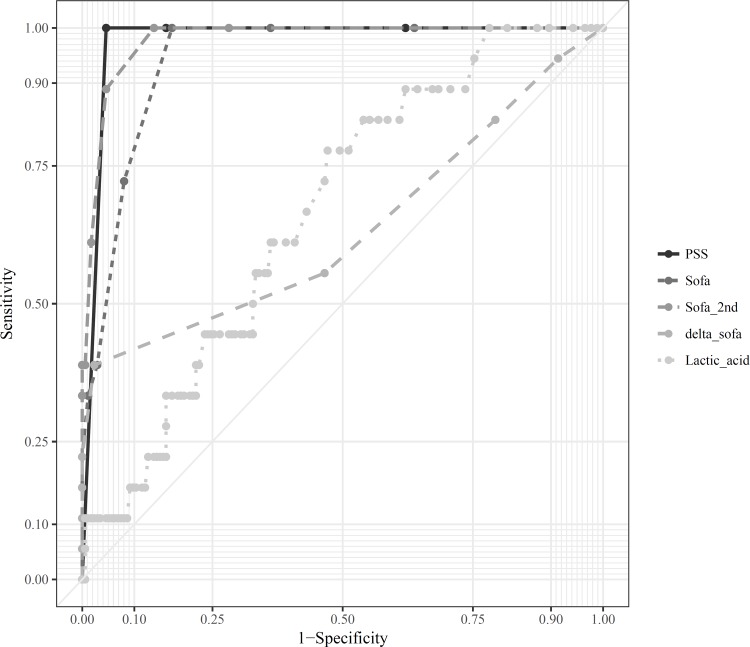
Receiver operating characteristic curve of PSS, SOFA, 2nd SOFA, delta SOFA, lactic acid to predict the poor outcome.PSS, poisoning severity score; SOFA, sequential organ failure assessment.